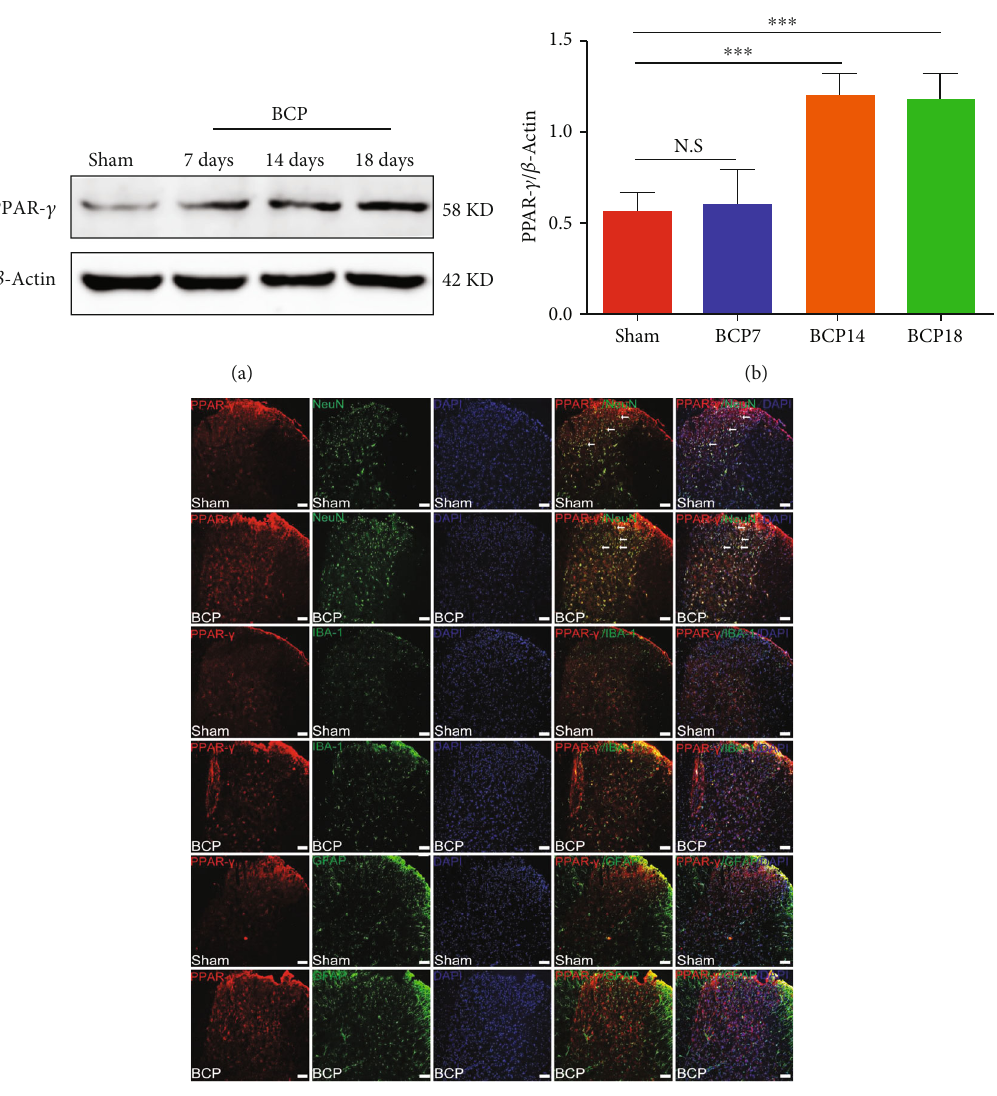
Figure 4: Endogenous expression and cellular localization of proliferator-activated receptor- γ (PPAR- γ ). (a, b) Western blot results revealed a signi fi cant increase in PPAR- γ expression at 14 and 18 days in bone cancer pain (BCP) rats ( ∗∗∗ p < 0 : 001 vs. the sham group; n = 4 , one-way ANOVA (a, b)). There was no di ff erence in the expression of PPAR- γ between rats in the sham group and BCP rats at 7days ( p > 0 : 05 vs. sham group; n = 4 , one-way ANOVA (a, b)). (c) Immuno fl uorescence results showed that in the dorsal horn of the spinal cord of BCP rats, PPAR- γ (red) was primarily expressed in neurons (green) rather than the astrocytes (green) or microglia (green). Lumbar enlargements were collected on day 18 after the operation or cancer cell inoculation. Sections were counterstained with DAPI (blue) to label cell nuclei. The white arrows indicate colocalization of PPAR- γ with NeuN (neuronal nuclei, neuronal-speci fi c marker), GFAP (glial fi brillary acidic protein, astrocyte-speci fi c marker), and IBA-1- (ionized calcium binding adapter molecule 1, microglial speci fi c marker) immunoreactive cells in the spinal dorsal horn, respectively; n = 4 . Scalebar = 50 μ m . n represents the number of experimental animals in each group. N.S: not statistically signi fi